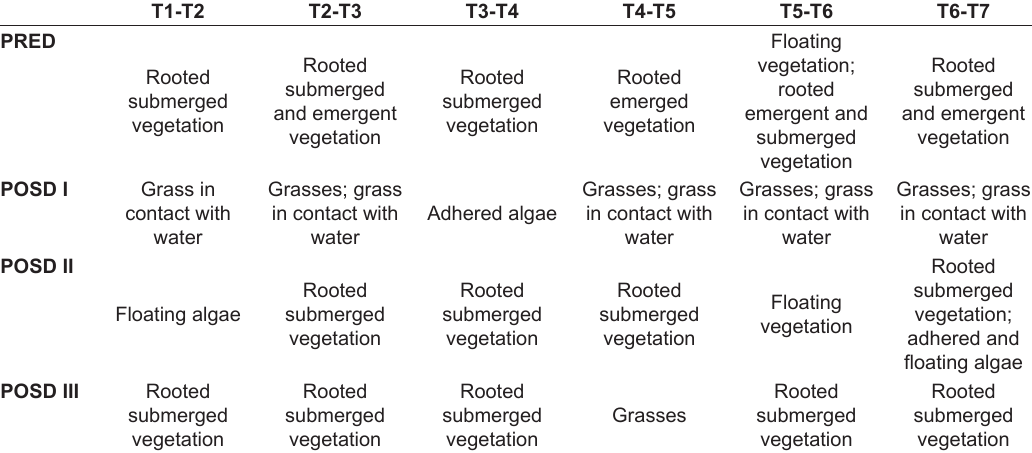
Table 2. Predominant vegetal cover composition between transects (form T1 to T7), in the sampled periods (pre-dis- turbance - PRED; post-disturbance I - POSD I; post-disturbance II - POSD II; and post-disturbance III - POSD